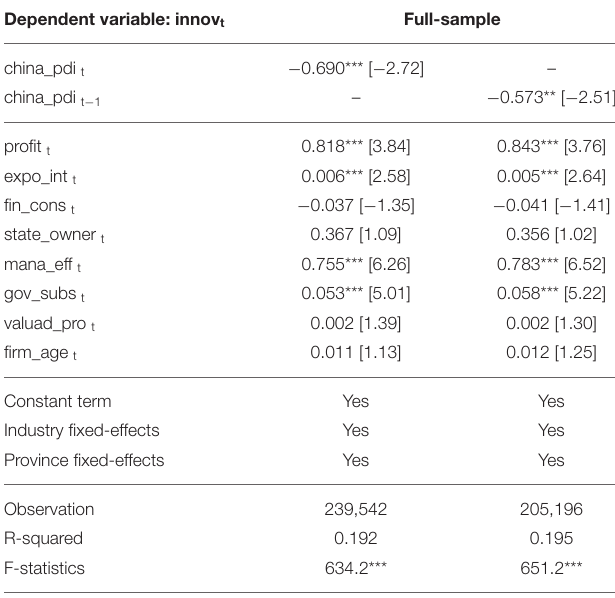
TABLE 3 | Results of the Benchmark fixed-effects estimations (current controls).